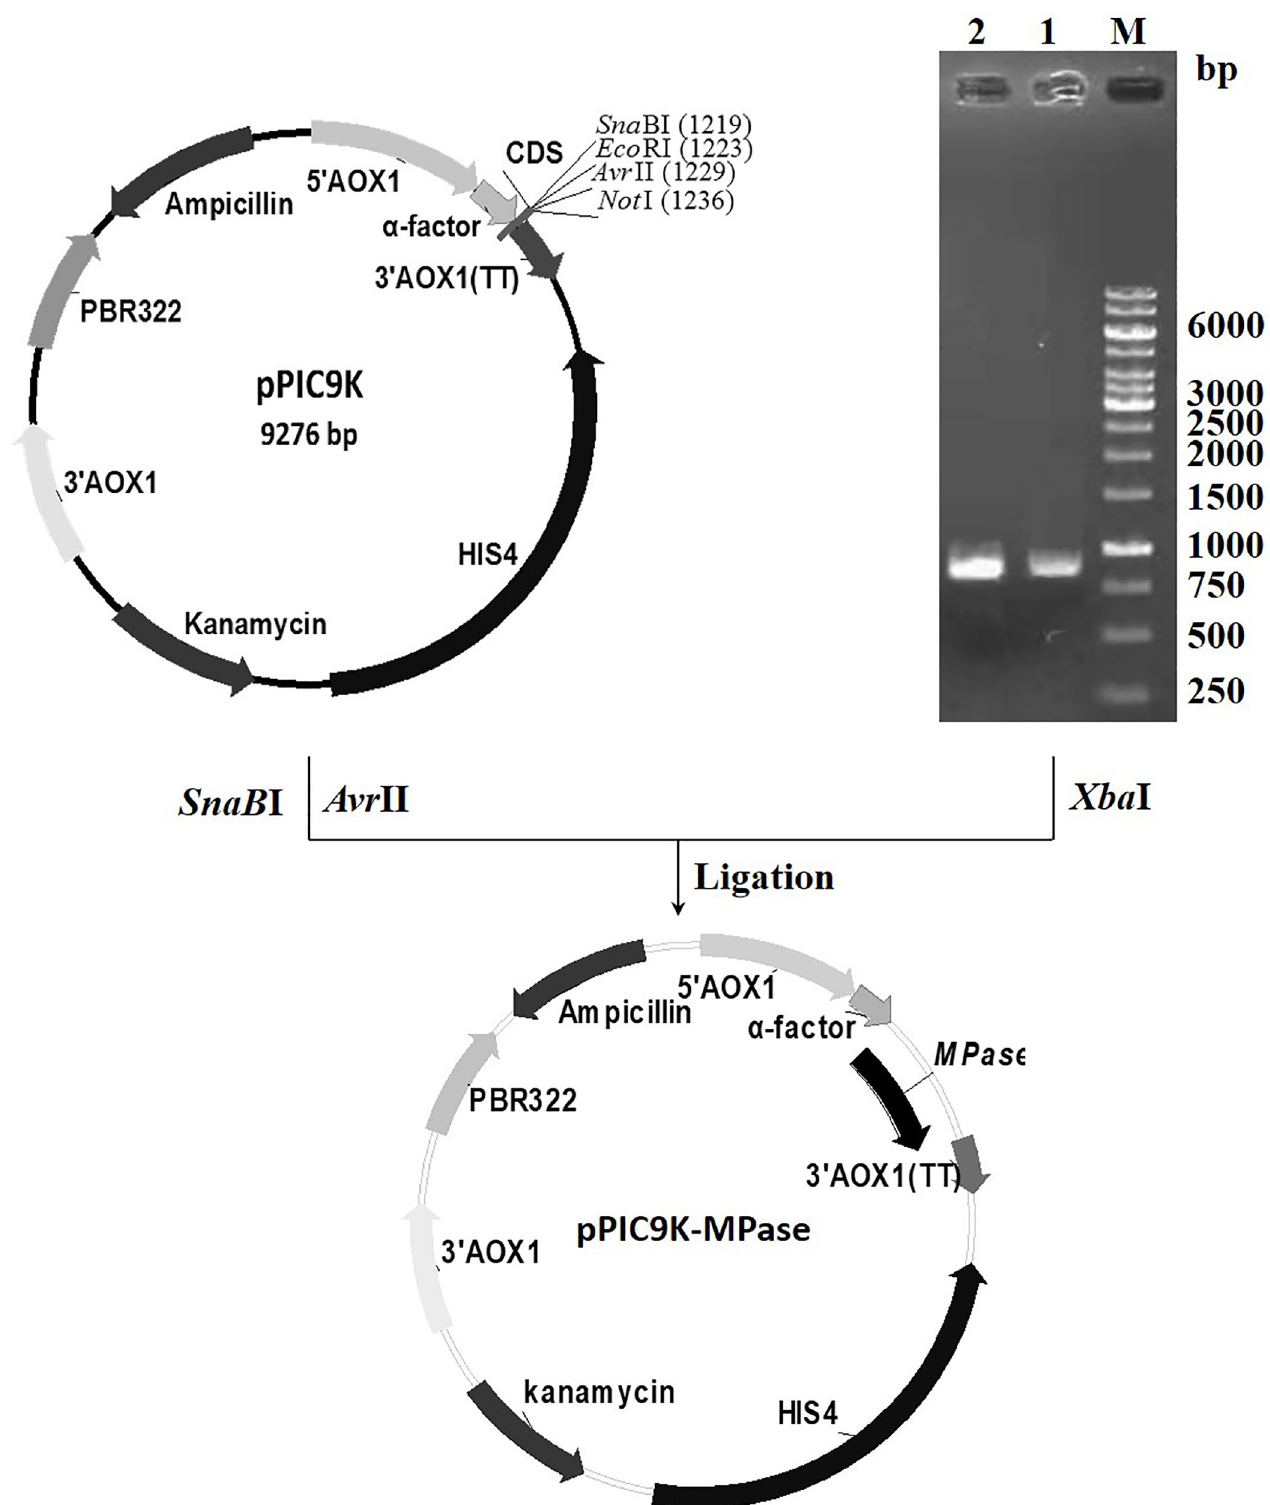
Fig 2. Construction of the expression vector pPIC9K-HypZn. The five bands from top to bottom are 4125 bp, 2555 bp, 1827 bp, 1241 bp and 377 bp.